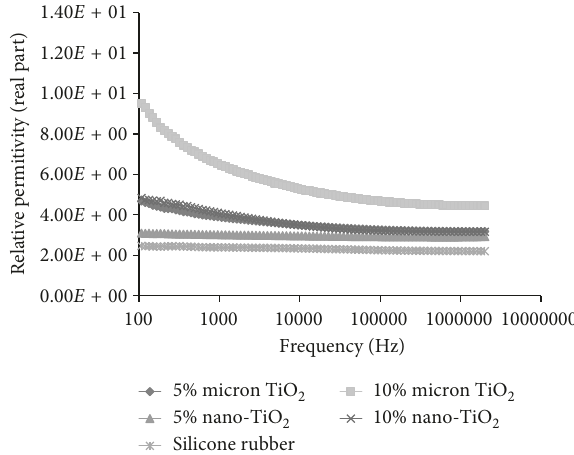
Figure 5: Real portion of relative permittivity at different loading fillers and its size in relation to